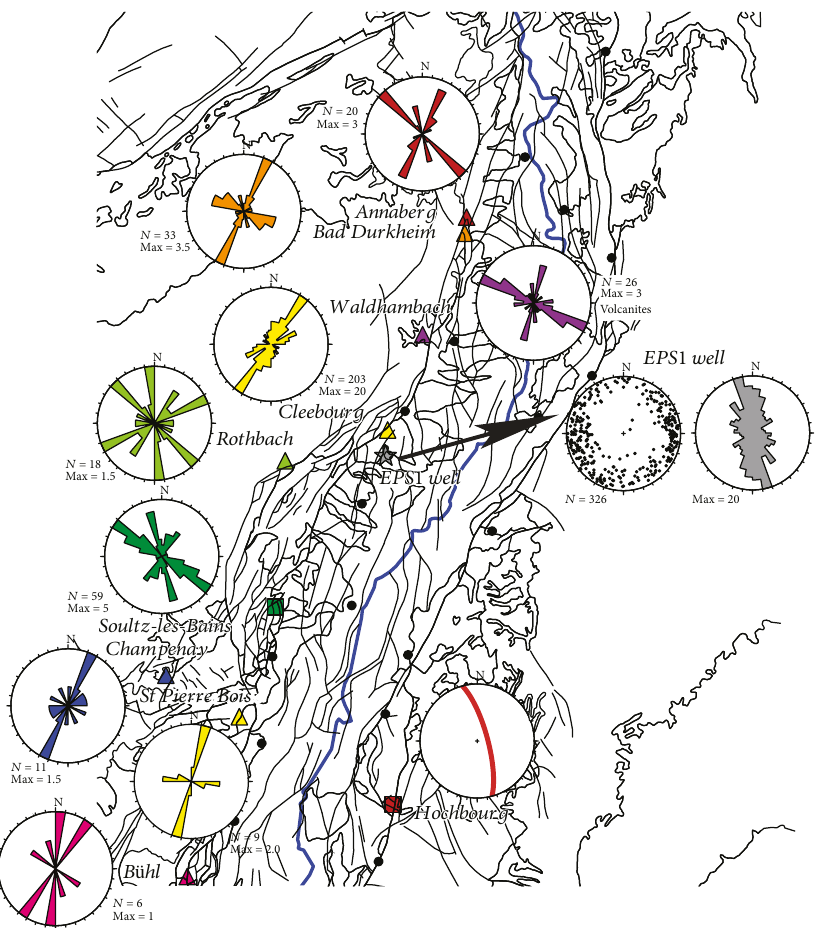
Figure 4: Fracture directions measured at the Permo-Triassic sandstone outcrops, including the measurements on cores of the EPS1 well and in Permian volcanic rocks at the Waldhambach quarry, represented on a structural map showing major structures. Bold lines represent the main faults and fi ne lines represent geological boundaries (same as Figure 1). For each site, the rose diagram shows the fracture directions in 10 ° classes. EPS1 well data, the plot diagram represents fracture pole in Schmidt ’ s projection, lower hemisphere. The di ff erent colors correspond to each site. The location of the sites is indicated by a square for outcrops, a triangle for quarries, and a star for